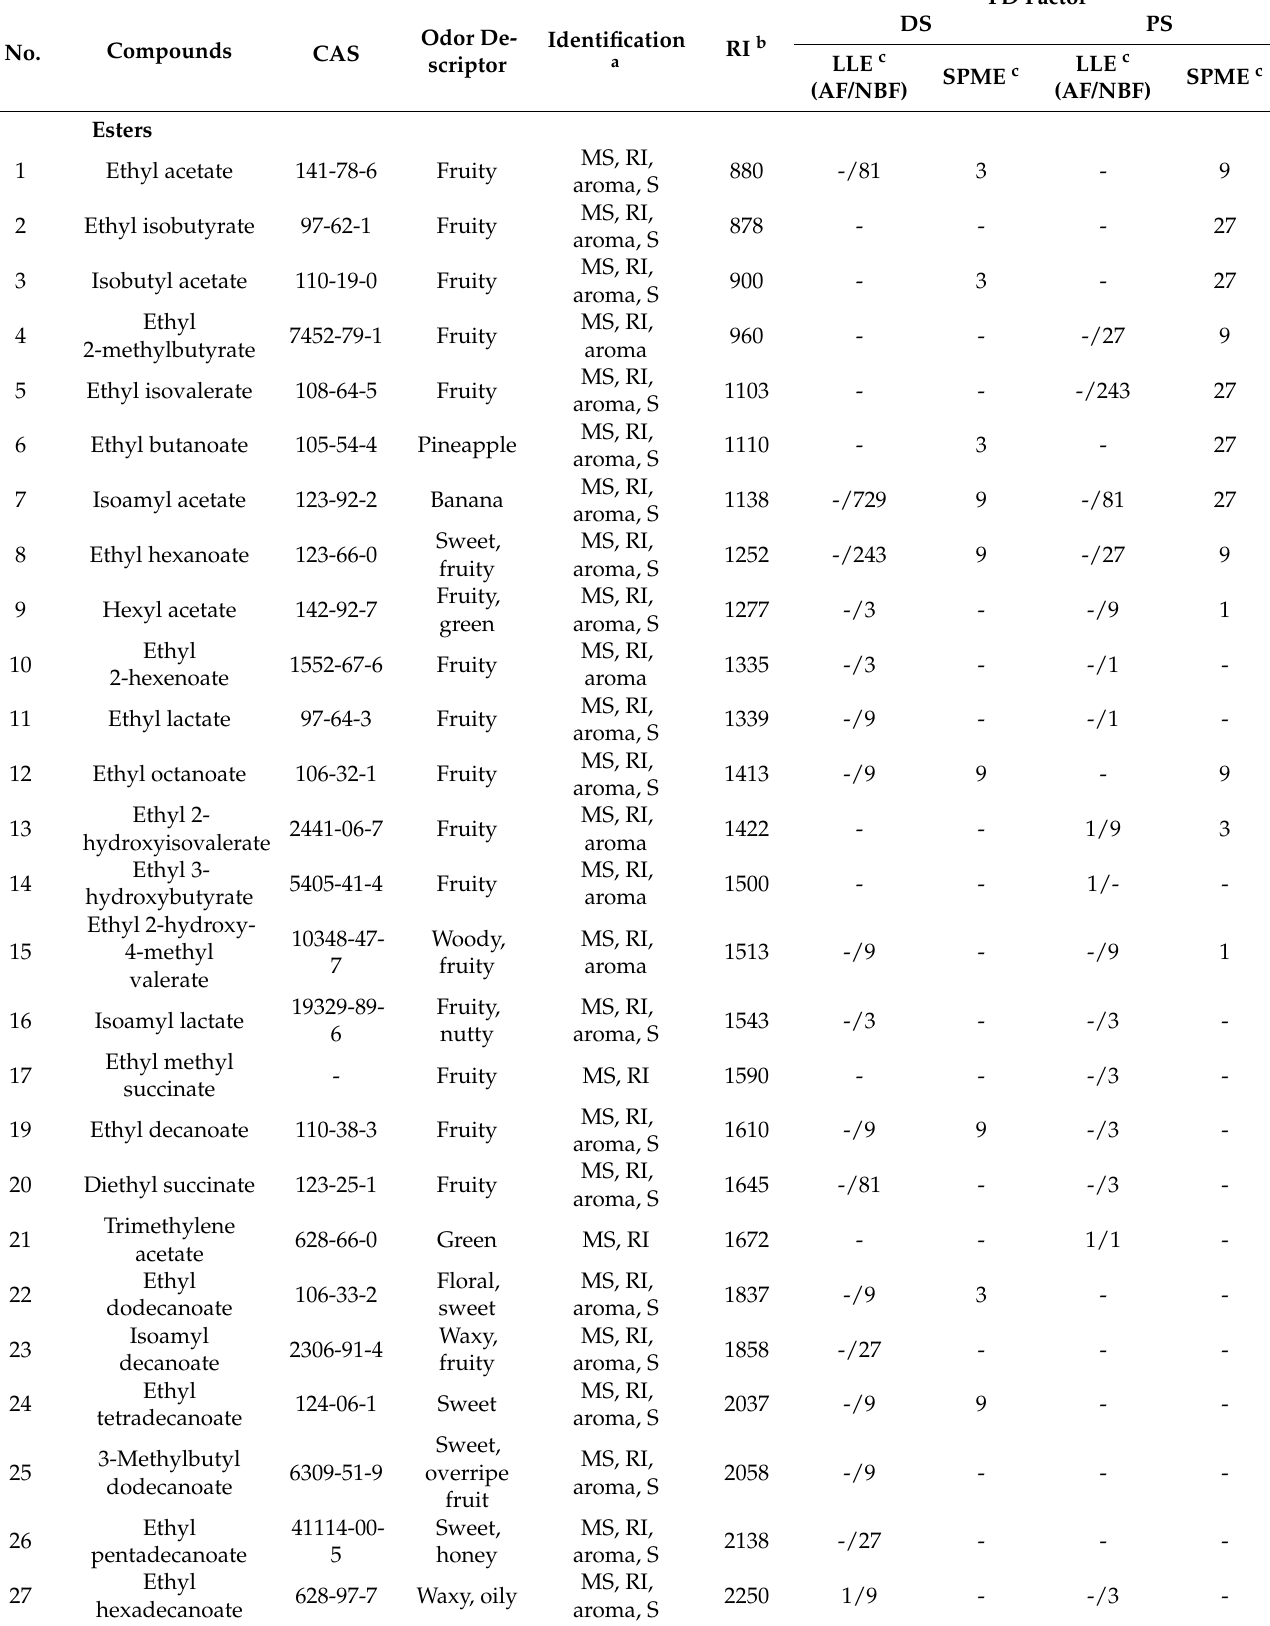
Table 1. Aroma-active compounds identified by GC-O-MS in peach